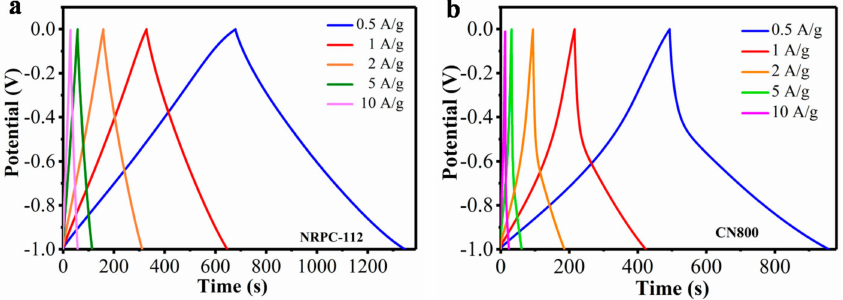
Figure 9. ( a ) Galvanostatic charge / discharge (GCD) curves at 0.5–10 A g − 1 of NRPC-112, ( b ) GCD curves at 0.5–10 A g − 1 of